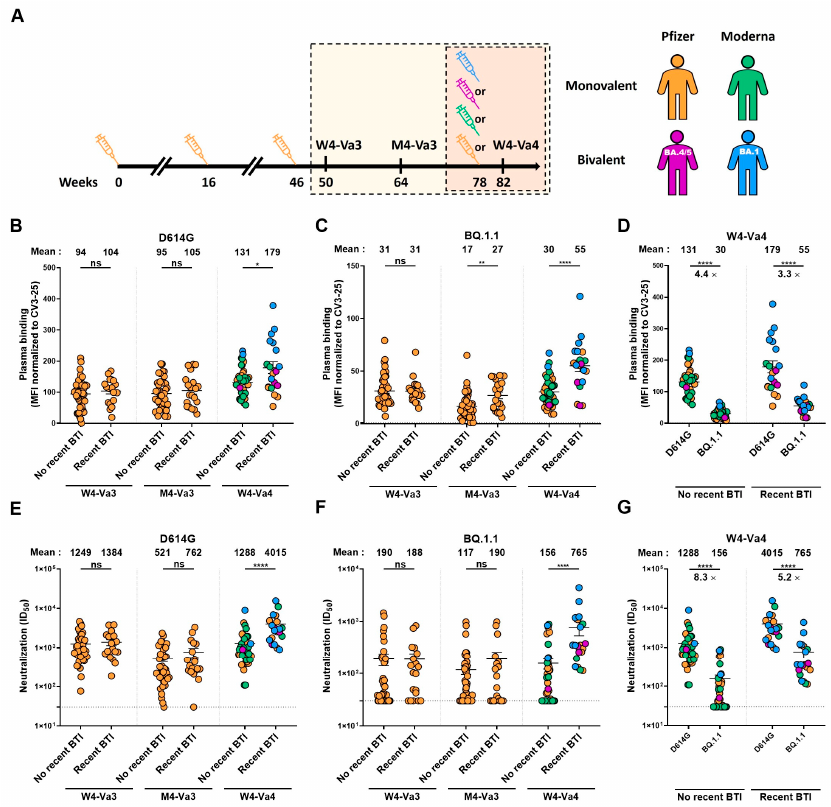
Figure 1. Recognition and neutralization of the D614G and BQ.1.1 Spikes after the third and fourth doses of SARS-CoV-2 vaccine in individuals with or without a recent breakthrough infection. ( A ) SARS-CoV-2 vaccine cohort design. The yellow box identifies the three timepoints under study shown in panels B, C, E and F and the red box the period presented in panels D and G. ( B – D ) 293T cells were transfected with the full-length D614G or BQ.1.1 S, stained with the CV3-25 mAb or with plasma from vaccinated individuals and analyzed by flow cytometry. The values represent the MFI normalized by CV3-25 mAb binding. ( E – G ) Neutralization activity was measured by incubating pseudoviruses bearing SARS-CoV-2 S glycoproteins, with serial dilutions of plasma for 1 h at 37 °C